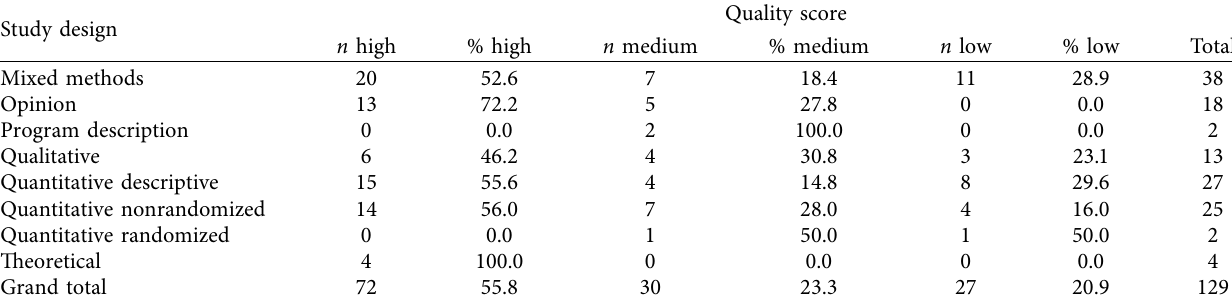
Table 8: Quality score by study